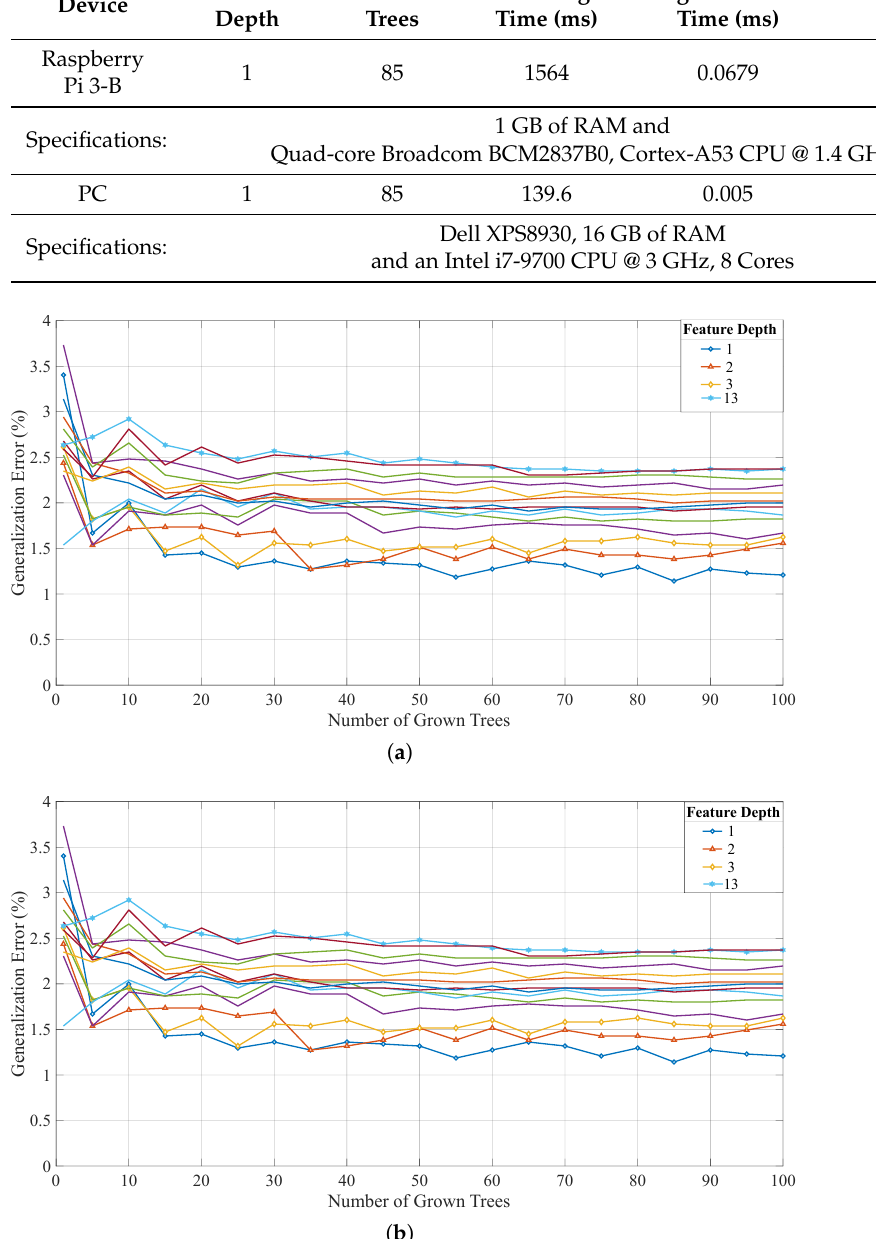
Figure 13. The generalization error for the designed scikit-learn Python Random Forest method using variable number of grown decision trees, variable feature depths and an unspecified maximum depth for each tree, where the error stabilizes between 1.14% and 2.57%. The same python scripts were implemented on ( a ) a Desktop PC and ( b ) a Raspberry Pi 3 Model